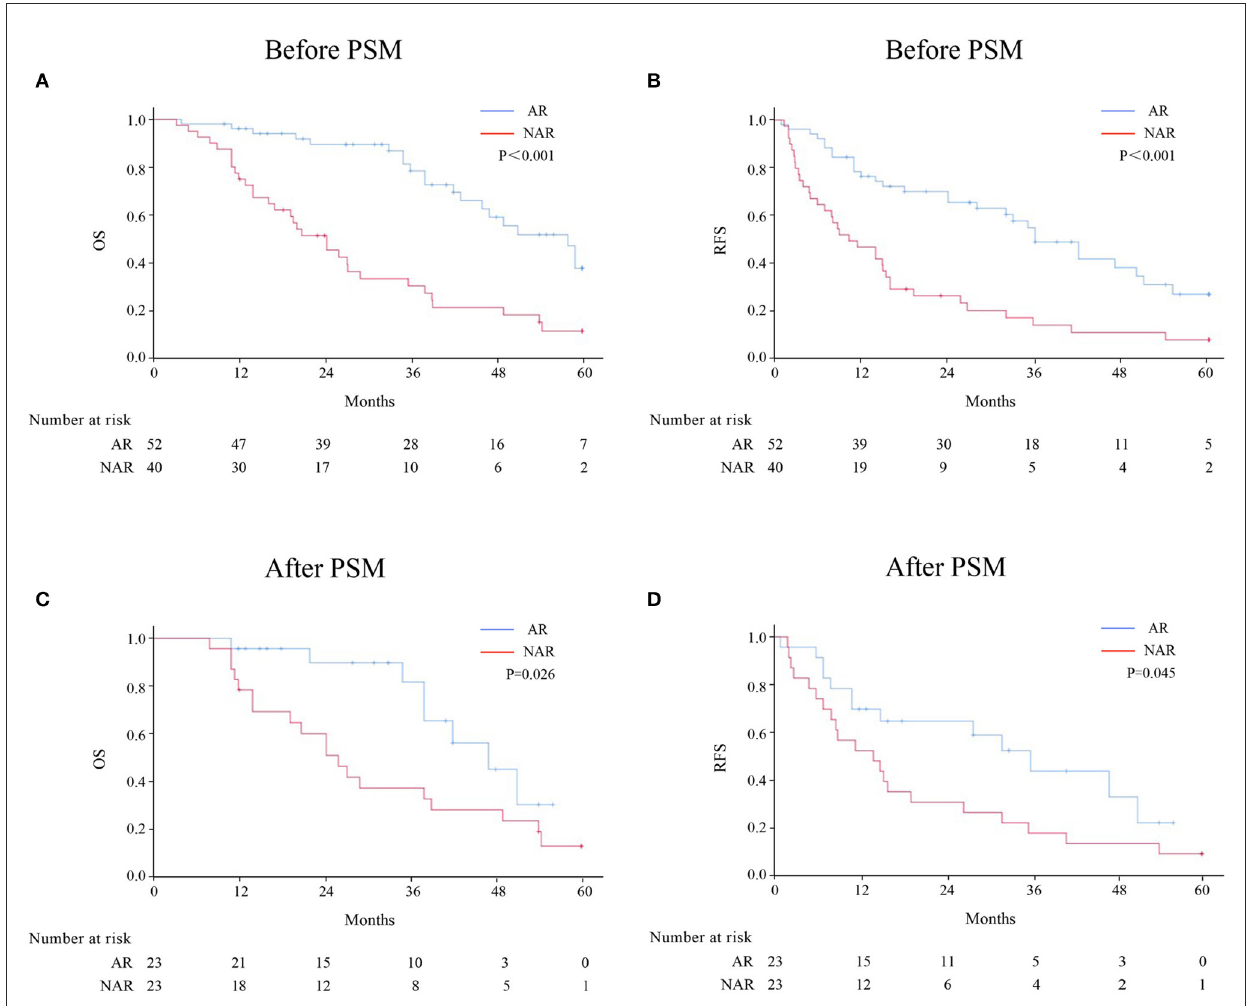
FIGURE2 OS and RFS rates after AR vs. NAR for HICC patients without LNM before (A, B) and after PSM (C, D) .